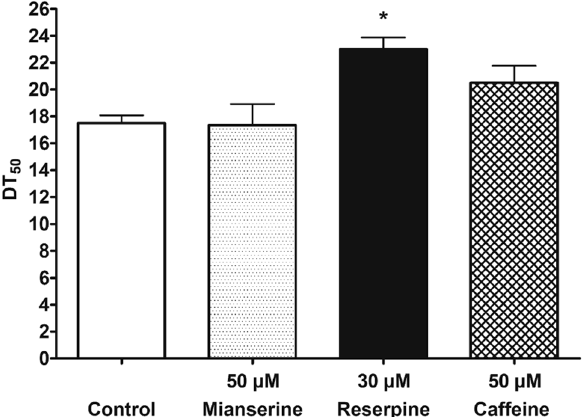
Figure 3. Screening of positive controls. Bar charts of mean DT 50 values of C. elegans treated with mianserine (50 µM), reserpine (30 µM) and caffeine (50 µM) in comparison to vehicle control. Reserpine at 30 µM significantly extended the DT 50 of wild type C. elegans by 31.4%. Bars represent the DT 50 value in comparison to the control group ± SD of three parallel experiments. Significance was assessed by one way ANOVA with Dunnett post-test (* p <